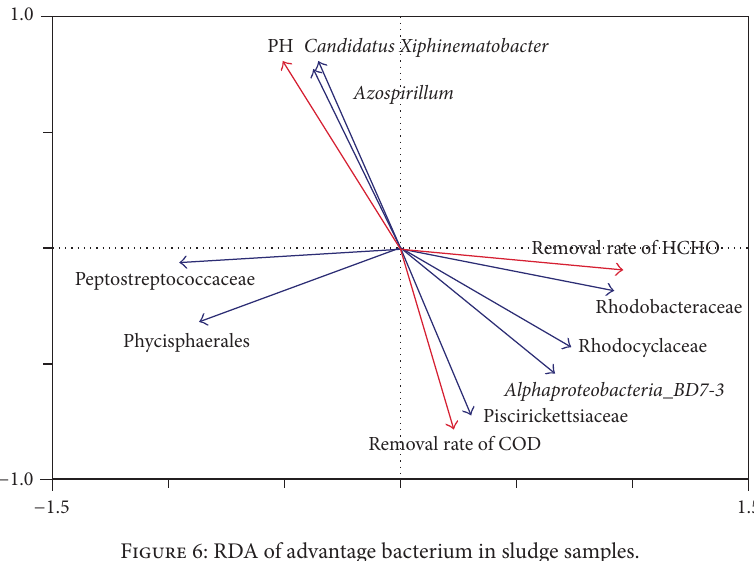
Figure 6: RDA of advantage bacterium in sludge